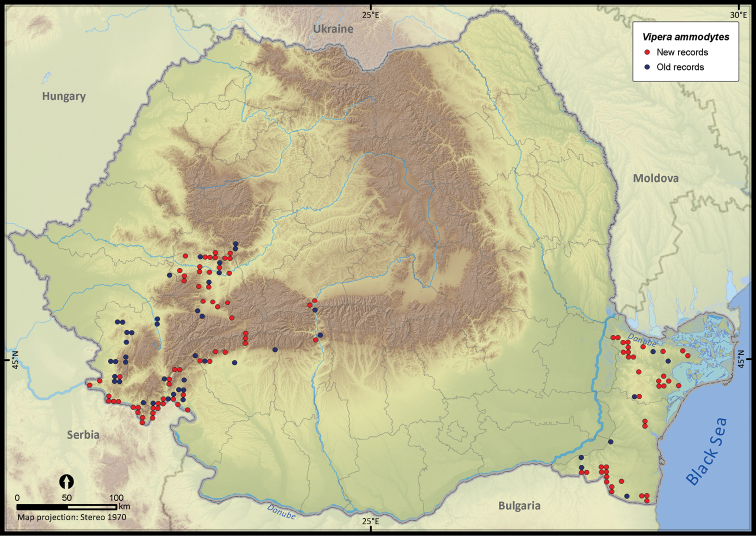
Vipera ammodytes.